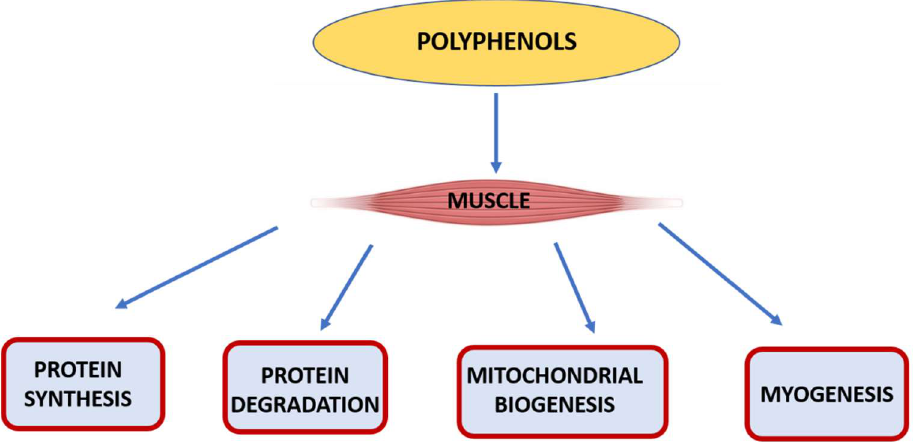
Figure 2. A schematic representation of the mechanism of polyphenols’ action on muscles. Adapted from [215].